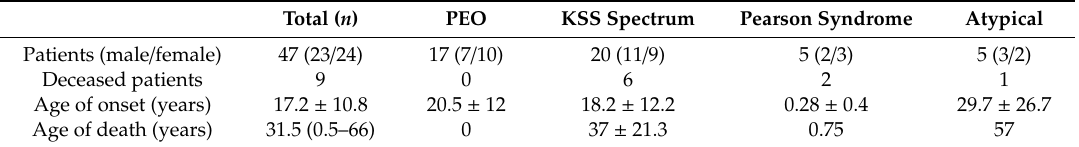
Table 1. General characteristics of 47 symptomatic